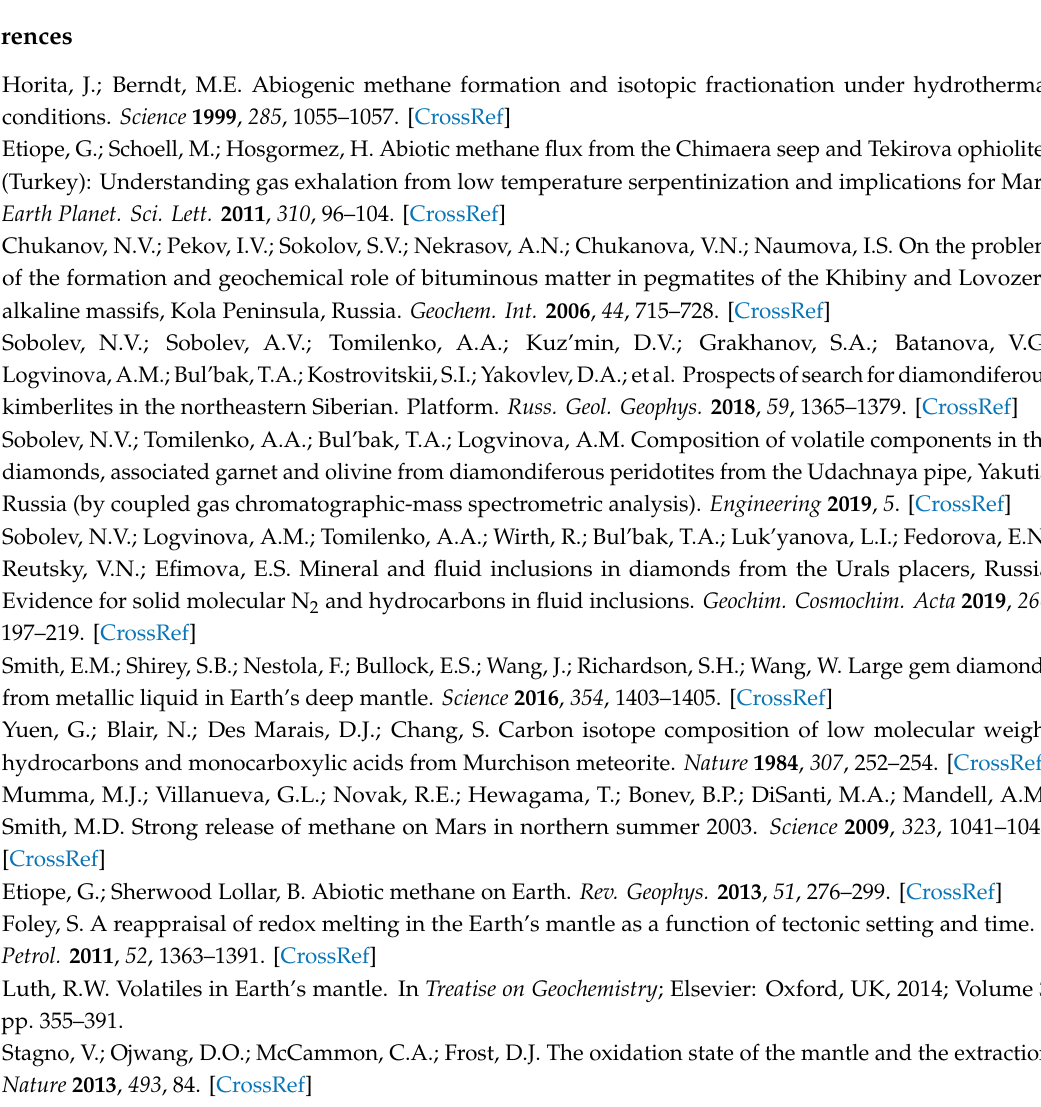
Table S1: Compositions of quenched fluid. Figure S1: (a) The high-pressure cell; (b) temperature patterns in furnace assembly predicted using the software of Hernlund et al. [74]; (c) the double-capsule technique used to constrain the f H 2 conditions by the assemblage Fe + FeO + H 2 O bu ff er. Figure S2: Results of GC-MS analysis of quenched fluid extracted by mechanical shock destruction from run 2095_2_4. Figure S3: Results of GC-MS analysis of of quenched fluid extracted by mechanical shock destruction from run 2095_2_4. Figure S4: Phases identified by X-ray powder di ff raction in the Gandolfi